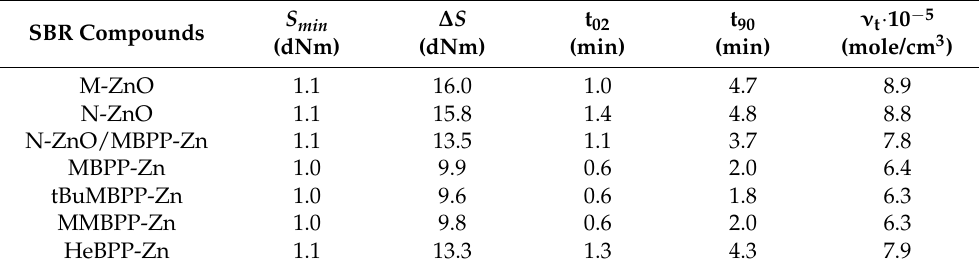
Table 3. Cure characteristics at 160 ◦ C and crosslink density of SBR composites containing ZnO and zinc complexes with 1,3-diketones as activators ( S min , minimum torque; ∆ S , torque increase; t 02 , scorch time; t 90 , optimal vulcanization time; ν t , crosslink density; SD: S min ± 0.1 MPa; ∆ S ± 2.0